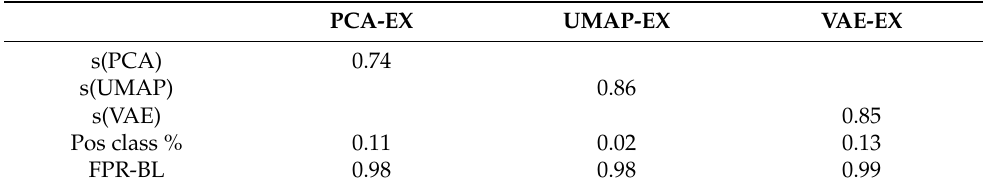
Table 4. Correlation of average classification results of the embedded classifiers (PCA-EX, UMAP-EX. VAE-EX) with the imbalance ratio (Pos class %) and baseline fingerprints classifiers (FPR-BL)